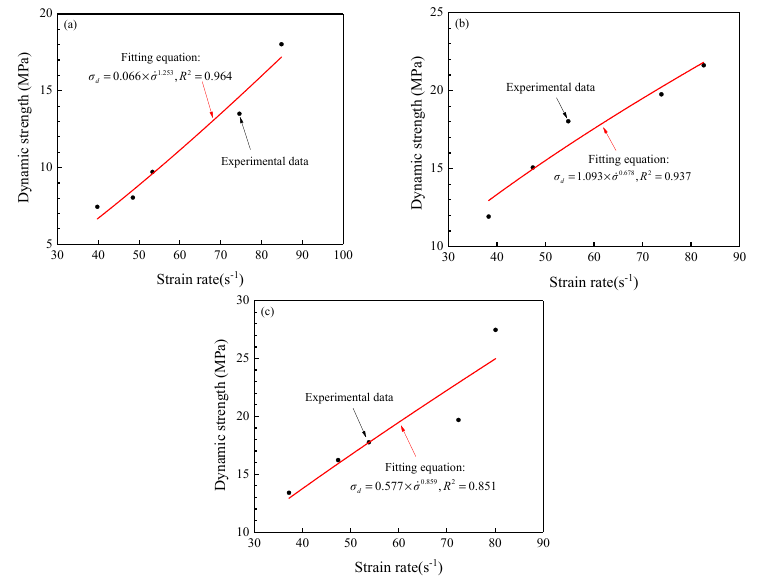
Figure 17. Dynamic strength dependence on strain rate in the S 5 series samples with different particle size distributions: Talbot indices ( a ) T = 0.5; ( b ) T = 1.0; ( c ) T = 2.0.